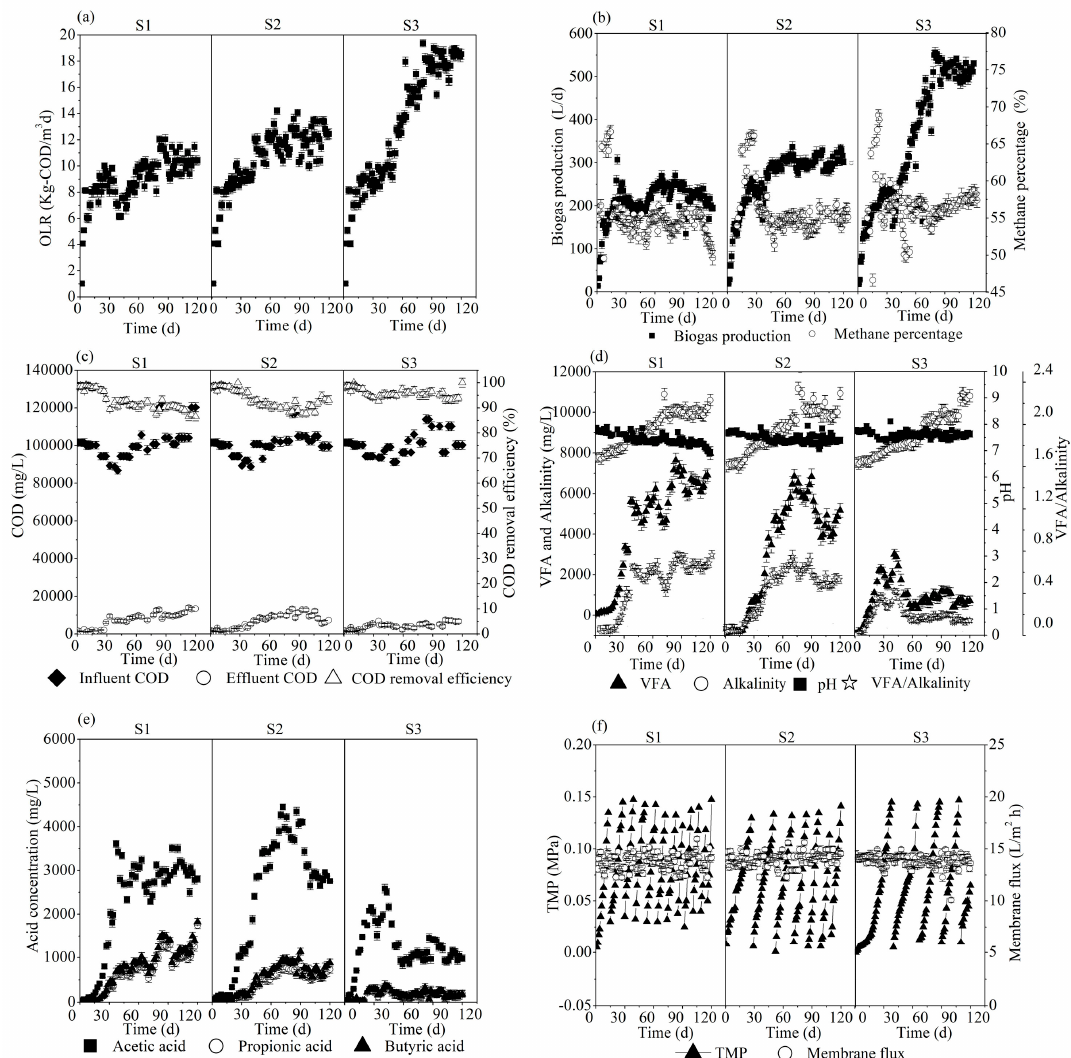
Figure 2. Reactor performance of the AnMBR reactor under cycle frequencies. ( a ) The OLRs variation; ( b ) The biogas production and methane content production; ( c ) The influent COD, permeate COD and COD removal efficiency variation; ( d ) VFAs, alkalinity, VFAs/alkalinity and pH variation; ( e ) The specific VFAs composition; ( f ) The membrane flux and TMP variation.